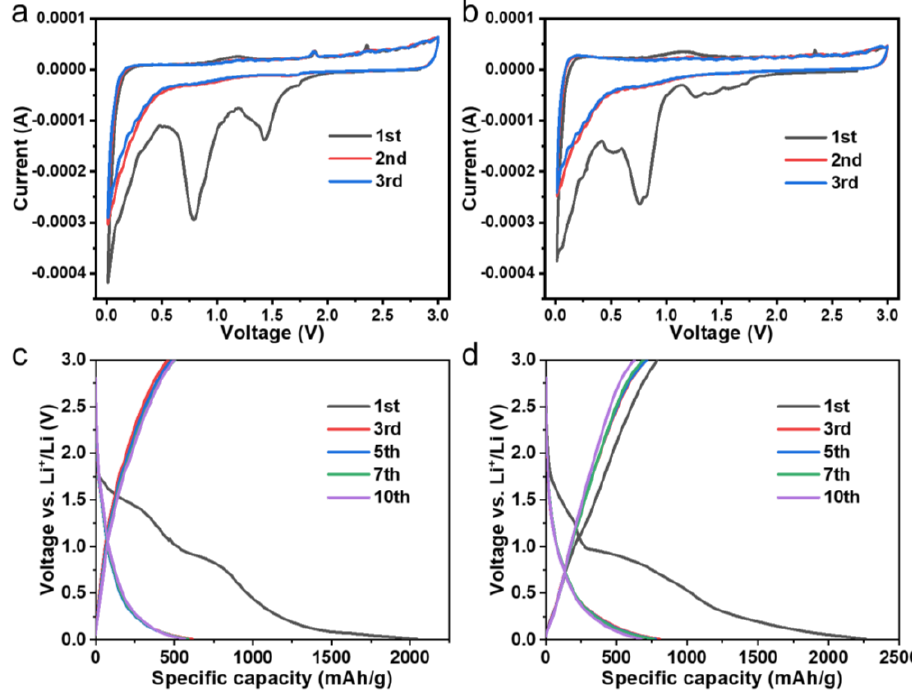
Figure 3. Cyclic voltammetry curves of ( a ) HCPB and ( b ) CHCPB at 0.1 mV s – 1 ; GCD curves of ( c ) HCPB and ( d ) CHCPB at a current density of 0.1 A g – 1 . ( c ) HCPB and ( d ) CHCPB at a current density of 0.1 A g –1